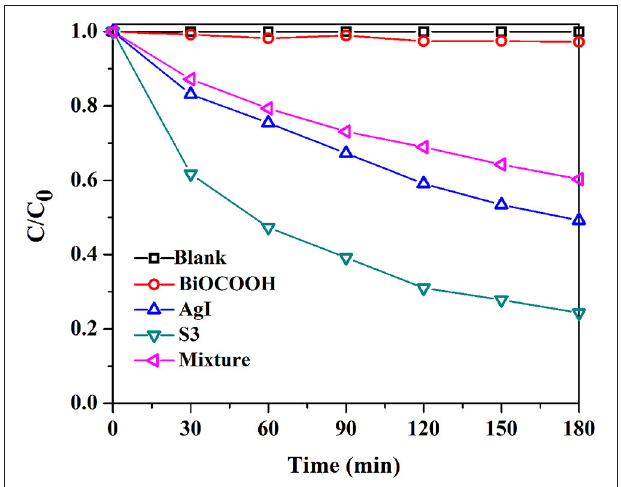
FIGURE 6 | The TC degradation curves over various catalysts under visible light.